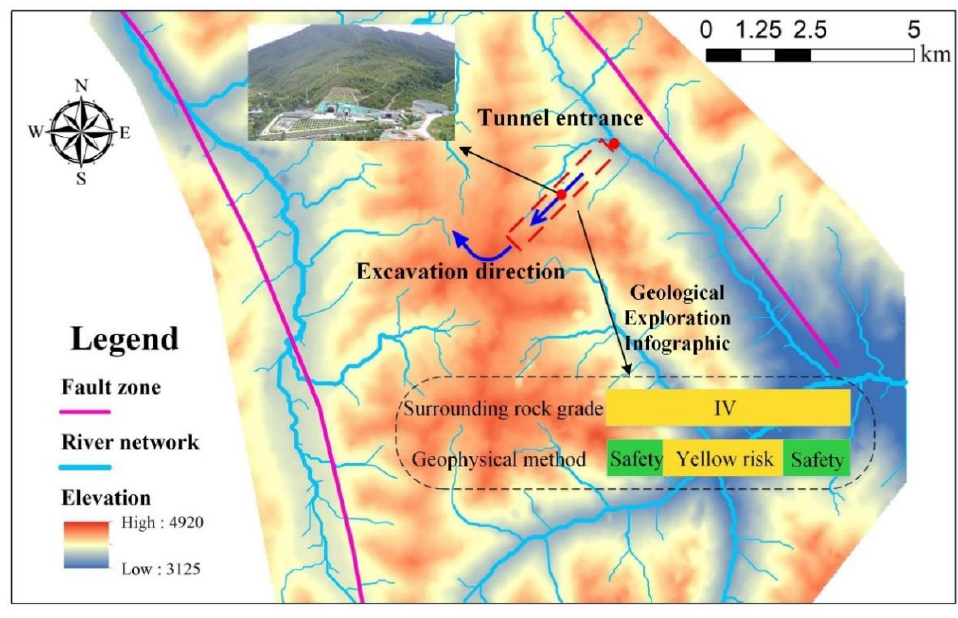
Figure 9. Study area location.